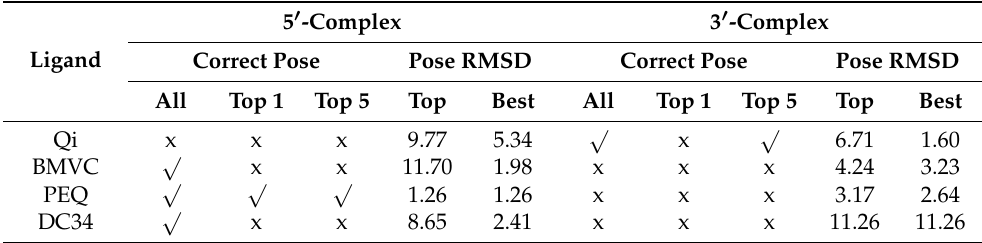
Table 1. Results obtained using AutoDock